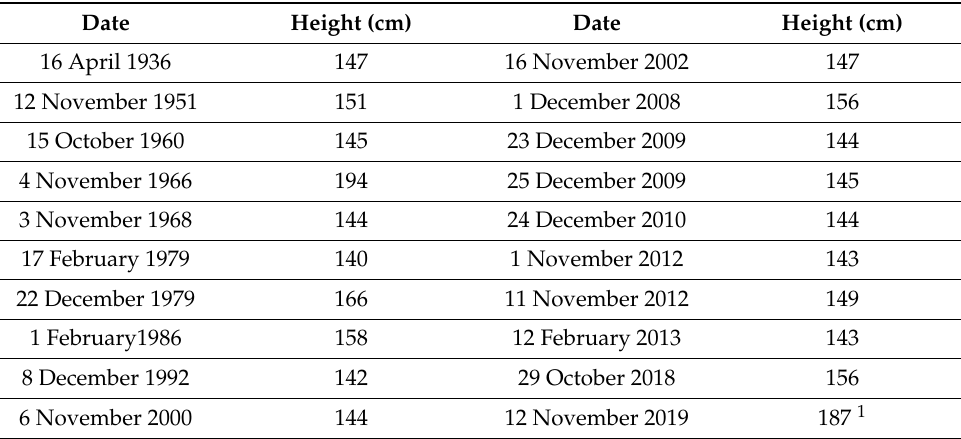
(available at https://www.comune.venezia.it/it/content/le-acque-alte-eccezionali, accessed on 15 November